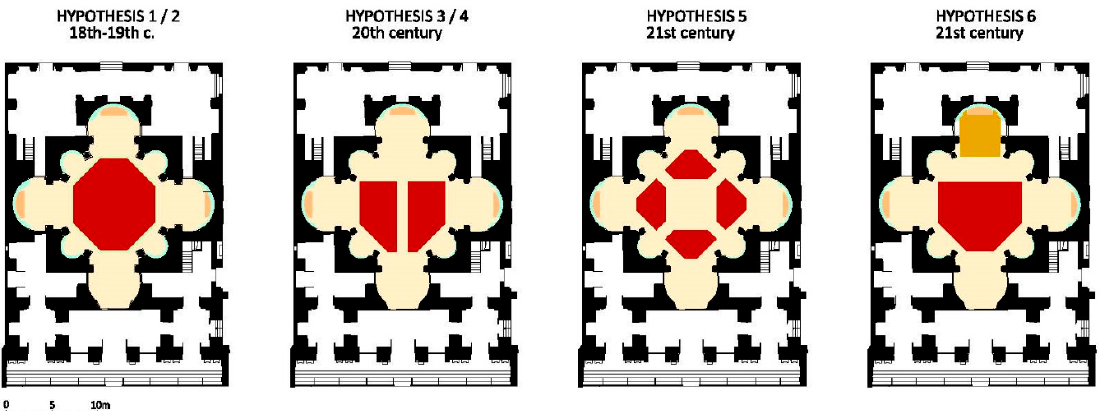
Table 6. Evolutionary hypotheses (* liturgy).